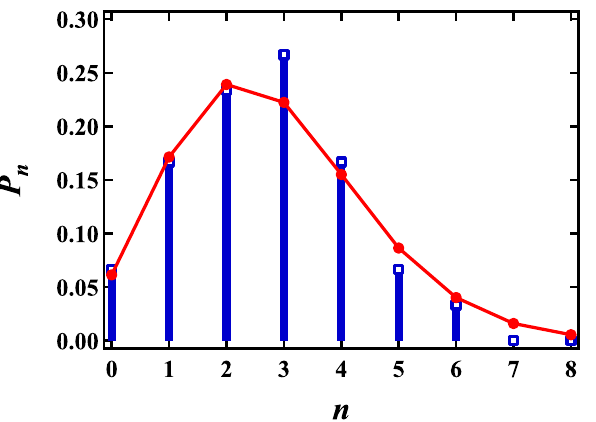
Figure 7. Probability distribution P n of n collective rearrangement events occurring over 5 τ for all foam samples (blue symbol). The red circles correspond to a fit with a Poisson distribution P ( n ) µ is a fitting parameter. We obtain µ =